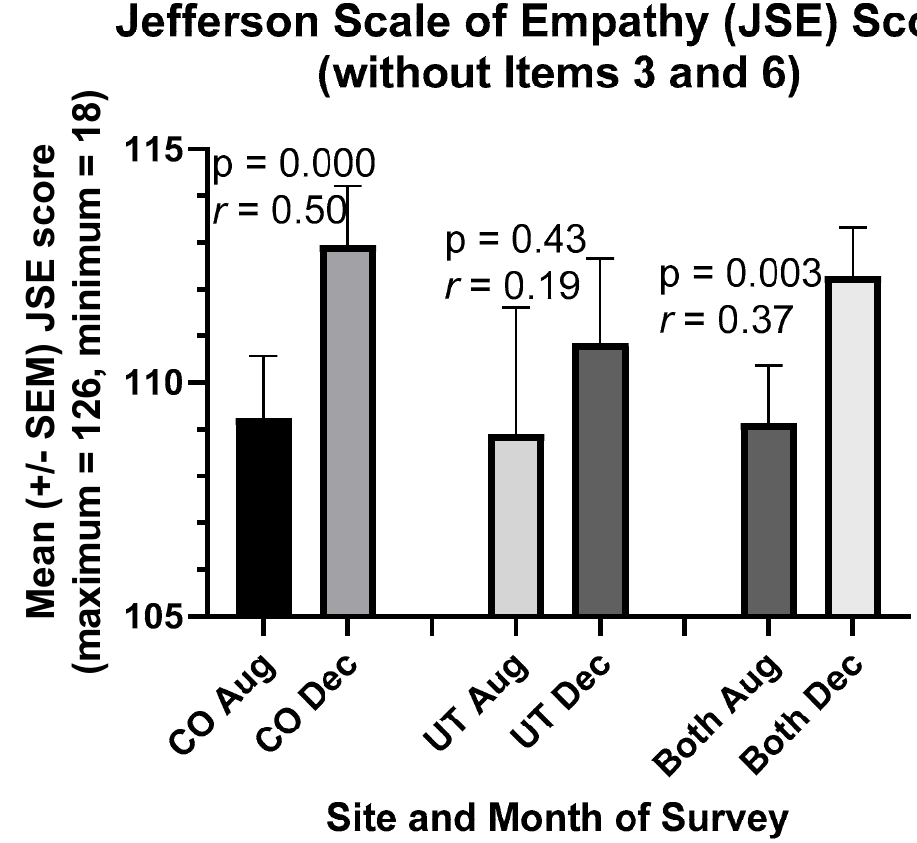
Figure 2. Students’ cognitive empathy (JSE) scores rose during their Medical Humanities course in 2020. Paired t -tests were used to compare means in Aug and Dec. n = 41 students in Colorado, 19 students in Utah, and 60 students combined (i.e., both). One student’s values were statistically significant outliers in Utah.